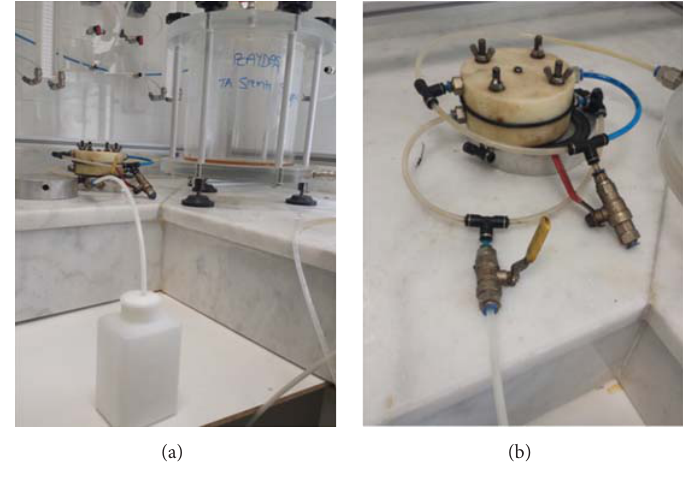
Figure 4: Leachate test arrangement: (a) leachate column; (b) test